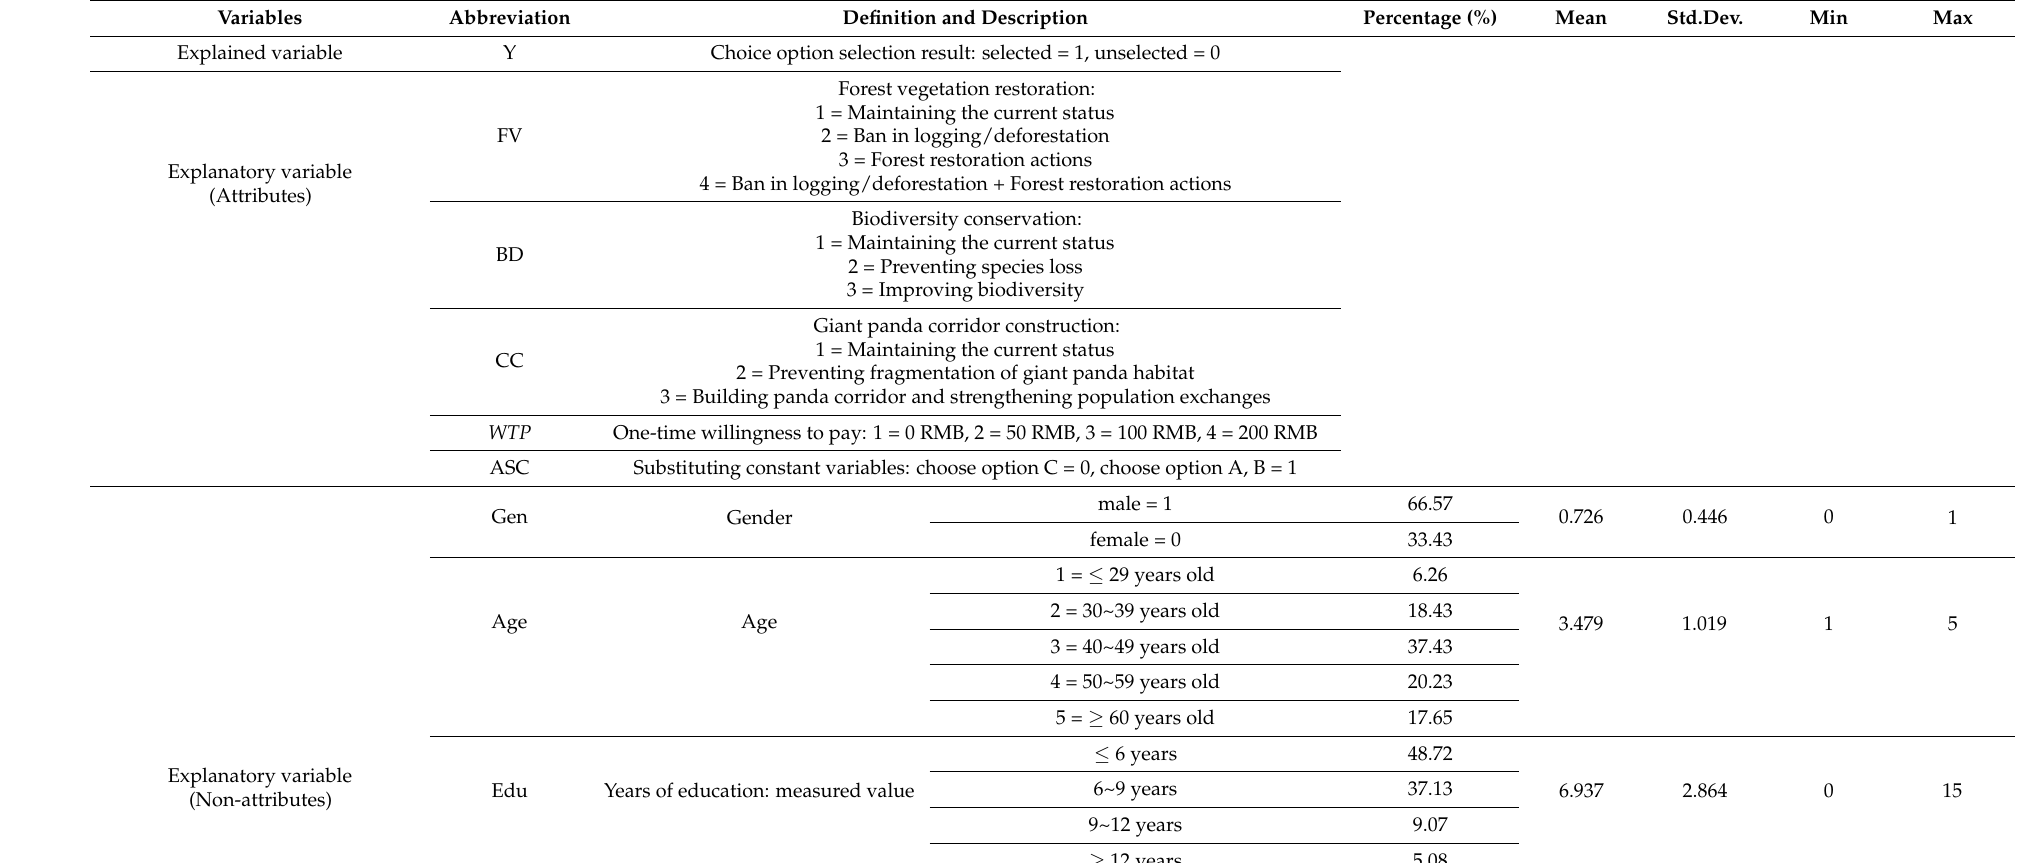
Table 1. Variable definition and